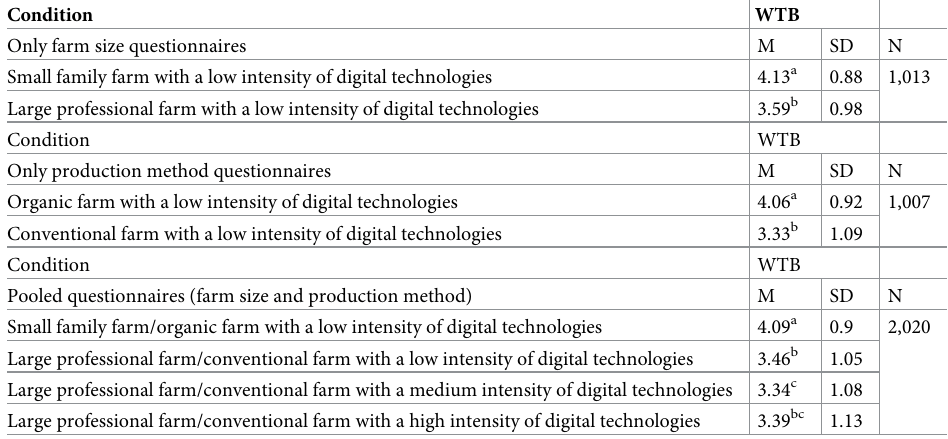
Note: Farm properties were within-subject conditions from repeated measures (ANOVA and Bonferroni post-hoc tests). Different superscripts within column indicate significant difference at p < .05. M stands for mean. SD stands for standard